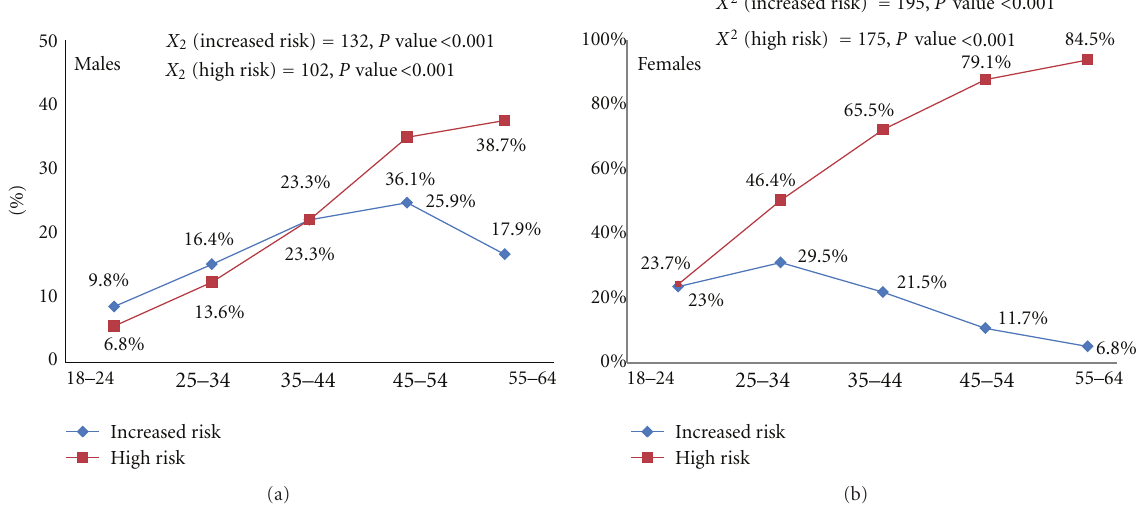
Figure 2: Prevalence of increased risk and greatly increased risk associated with high waist circumference by gender and age group: findings of the first national health and nutrition survey (FNHANS)